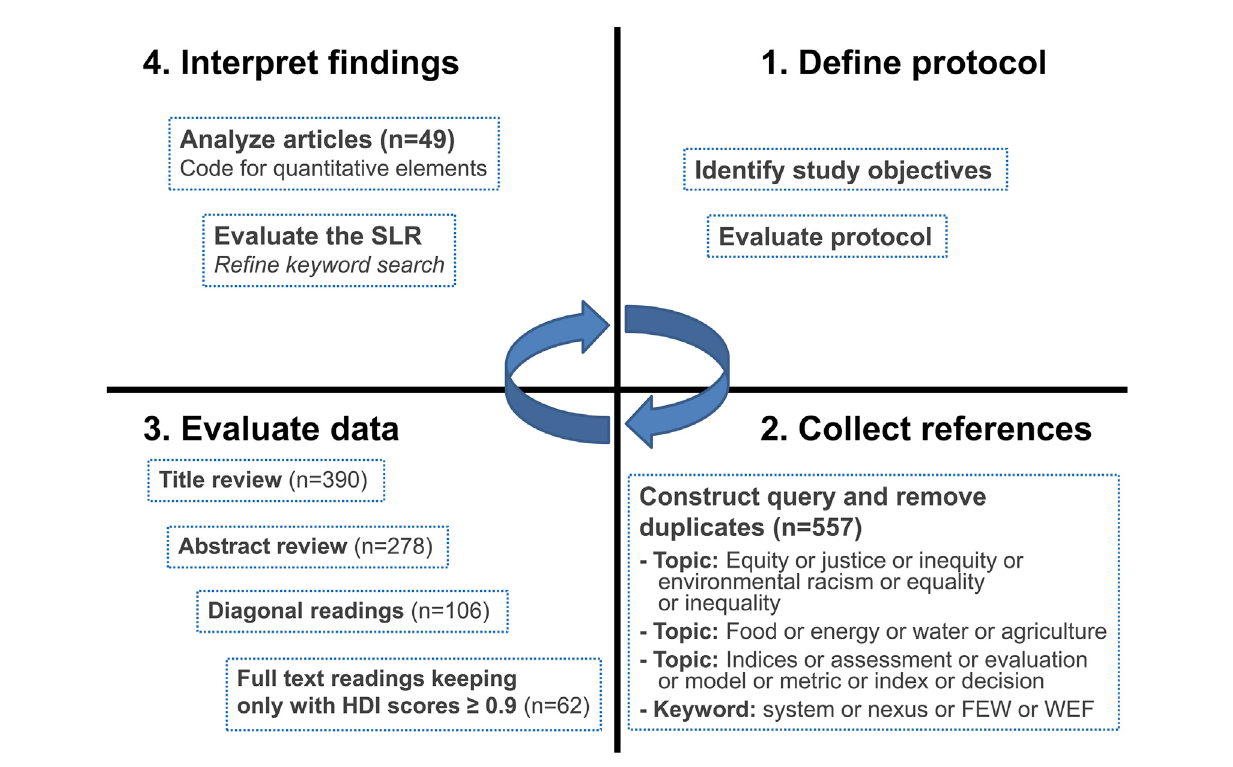
FIGURE 1 The process schematic for this social equity in FEWS analyses systematic literature review (SLR) followed PRISMA (Preferred Reporting Items for Systematic Reviews and Meta-Analyses) and a framework developed by Marianao et al. (2017). The four-stage process is iterative and constructed to reduce bias in article selection. The notation “ n = ” refers to the number of articles reviewed at each stage of the